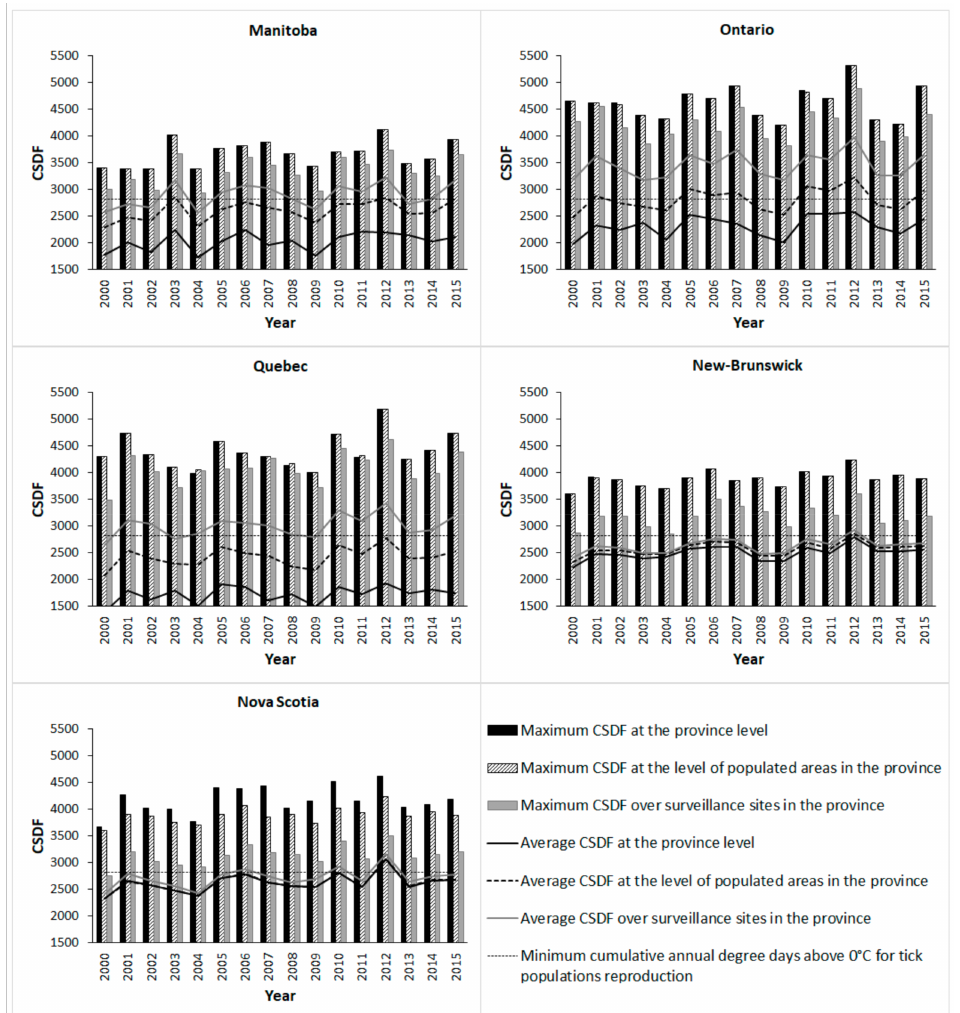
Figure 6. Variation of cumulative annual surface degree days above >0 ◦ C of forest covered areas (CSDF) from 2000 to 2015 at provincial, populated area, and tick surveillance site